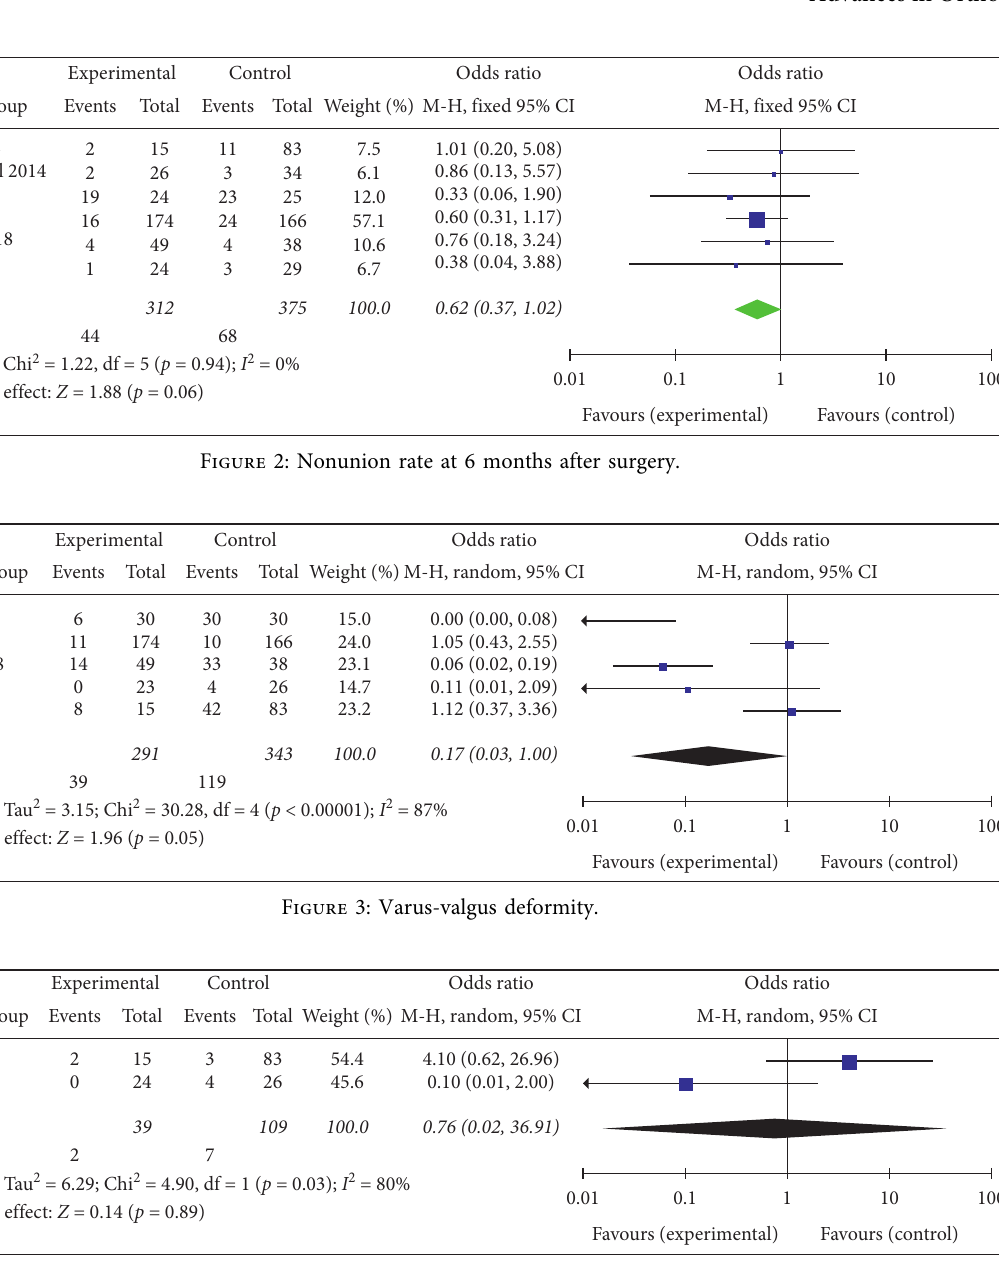
Figure 4: Anterior-posterior deformity.